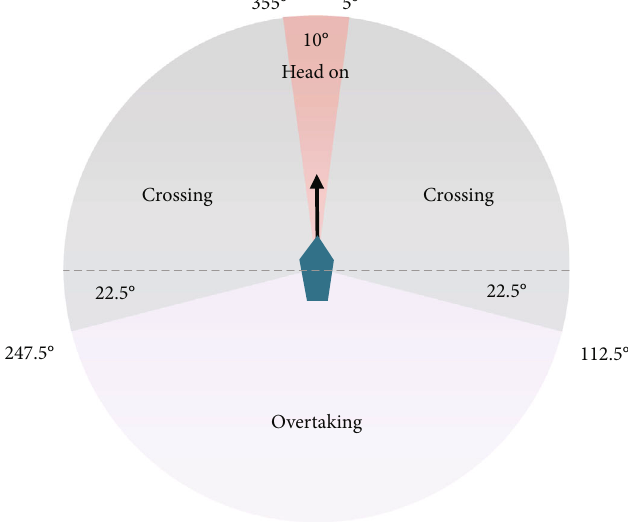
Figure 5: The classi fi cation of di ff erent ship encounter